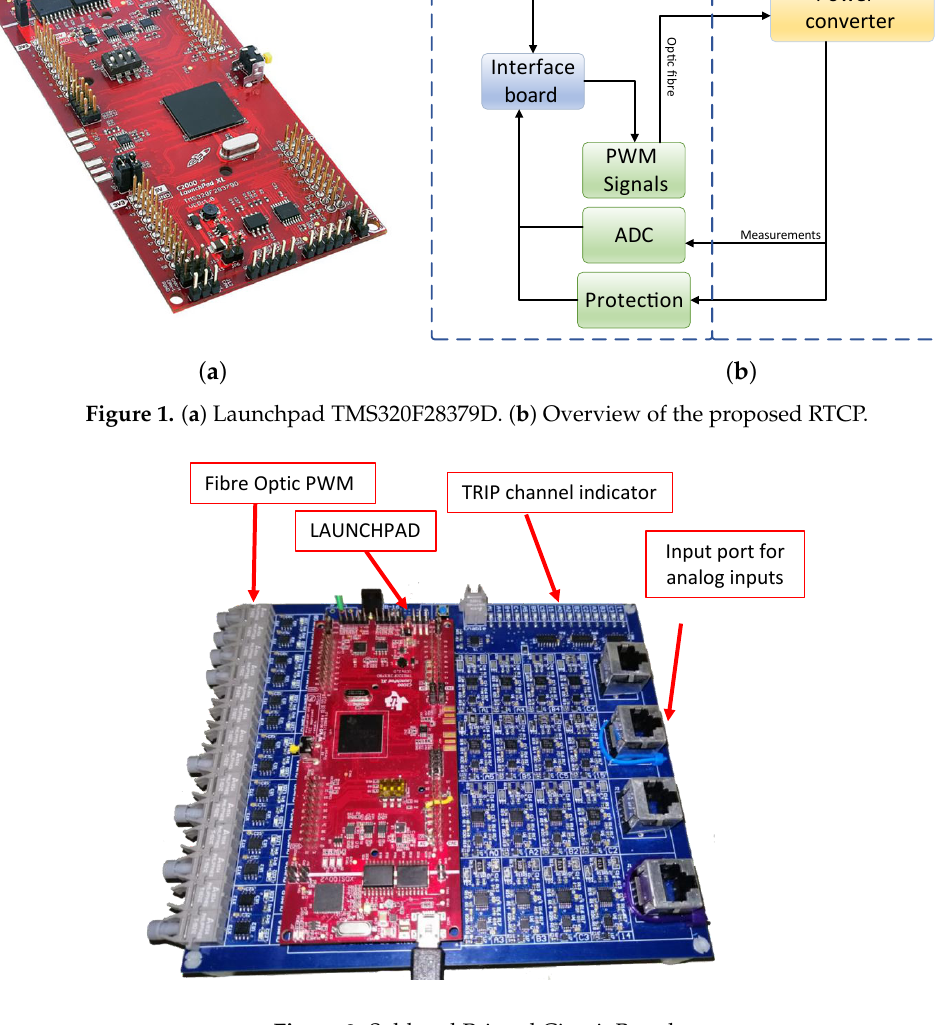
Figure 2. Soldered Printed Circuit